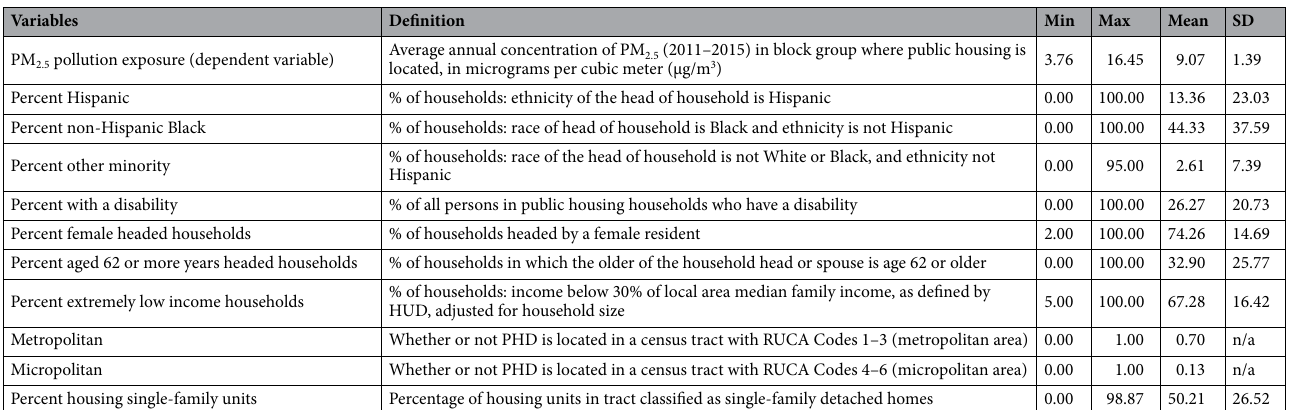
Table 3. Public housing development level analysis: Variable definitions and summary statistics. N = 6685 PHDs with complete data for all independent